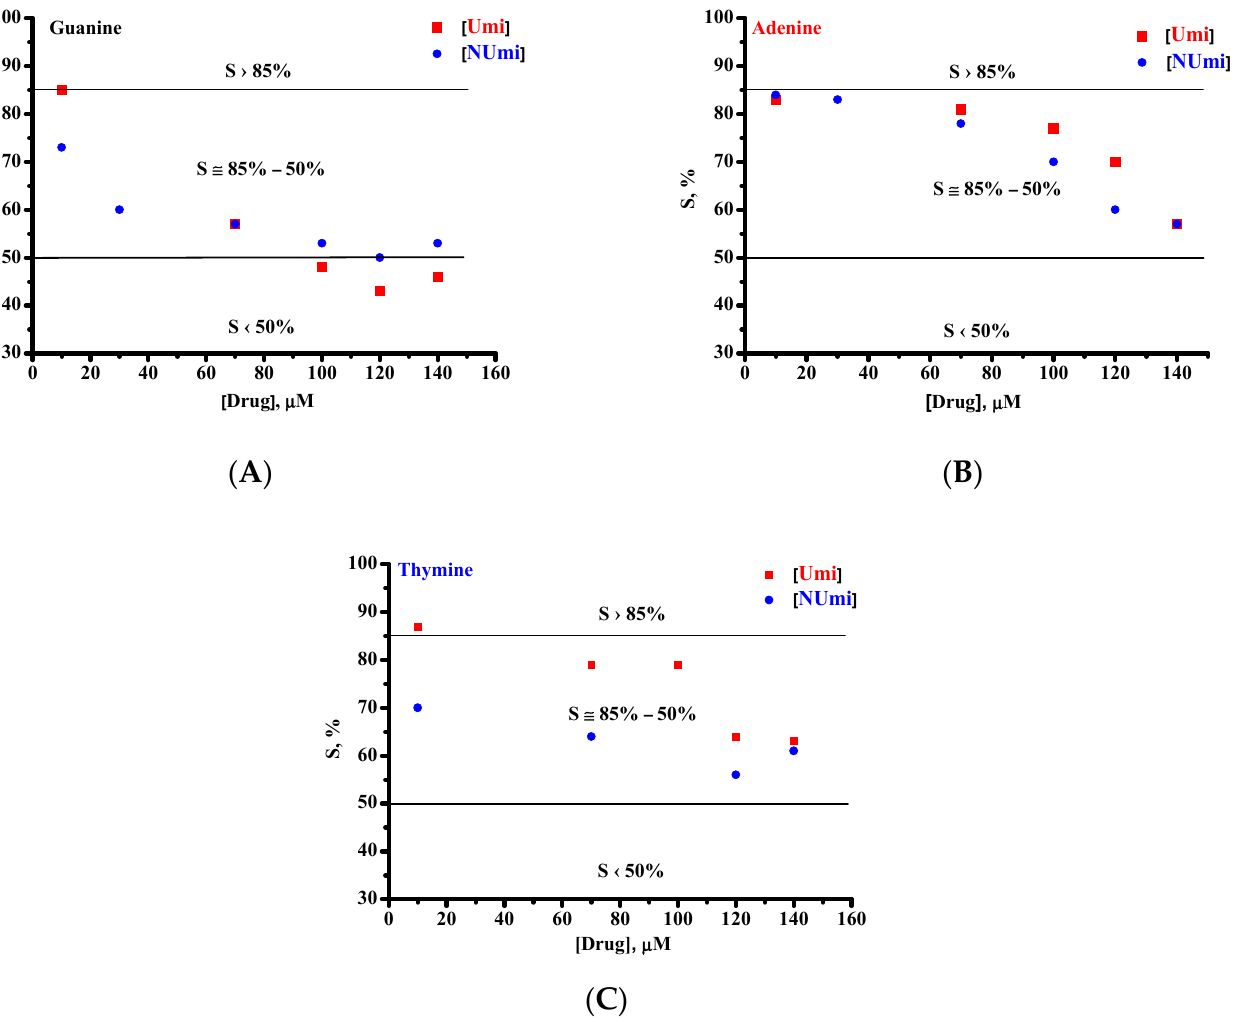
Figure 5. The influence of antiviral drug umifenovir (Umi) and umifenovir encapsulated in phos- pholipids micelles (nanosome/umifenovir, NUmi) in the concentration range of 10–150 µM on DNA oxidation signals of ( A ) guanine, ( B ) adenine and ( C ) thymine. S , %—DNA-mediated the electrochemical decline coefficient.